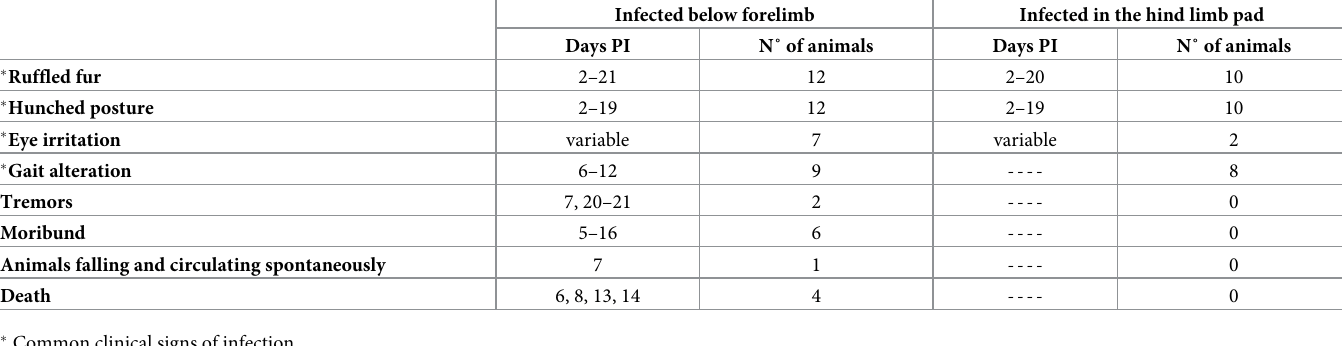
Table 1. Clinical signs observed in Balb / c mice during virus infection Mayaro.